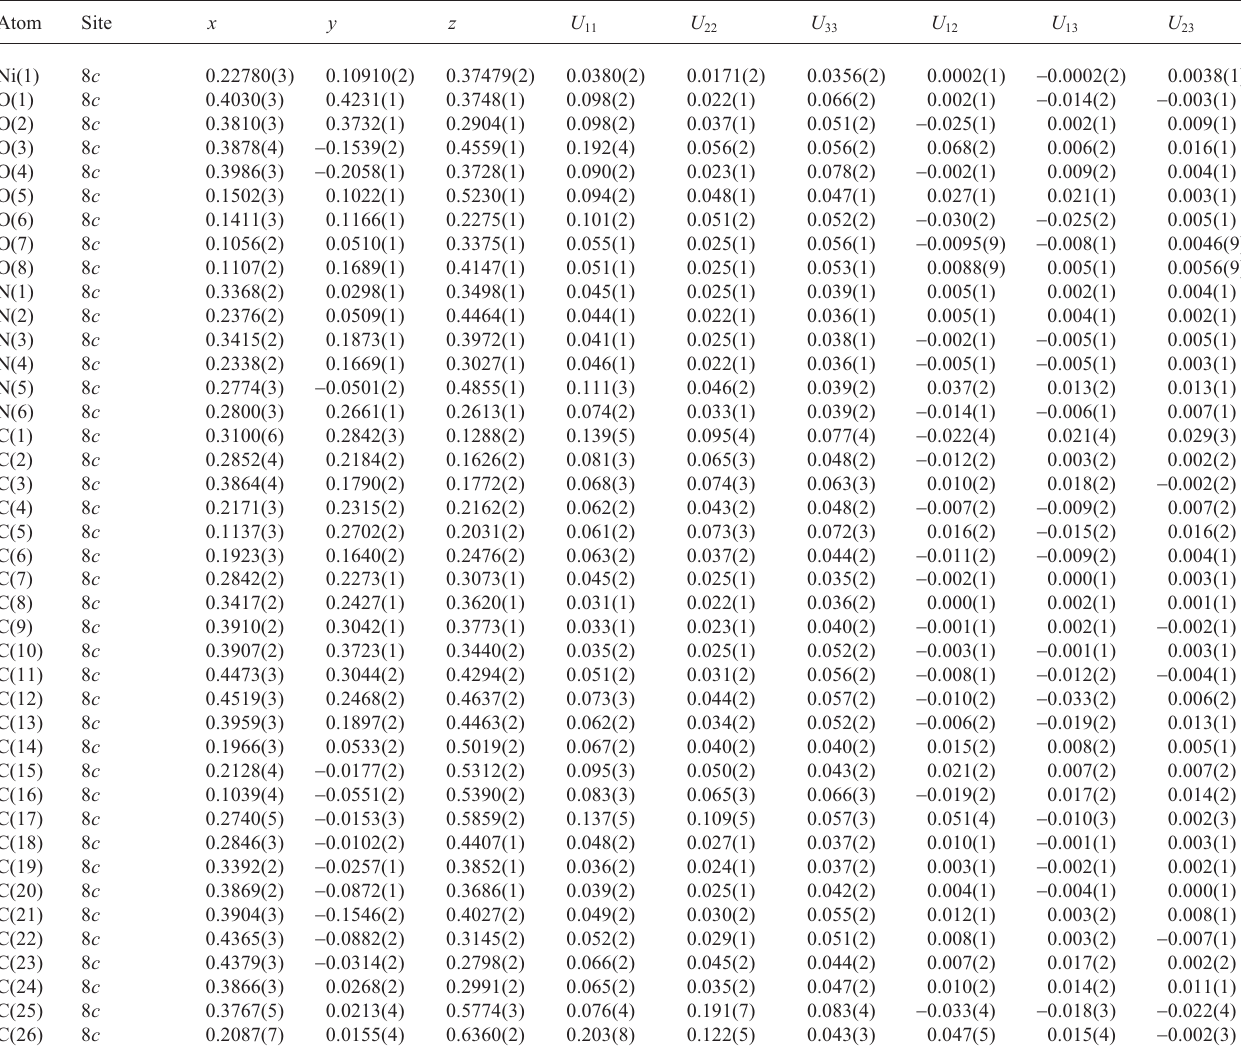
Table 3. Atomic coordinates and displacement parameters (in Å 2 )